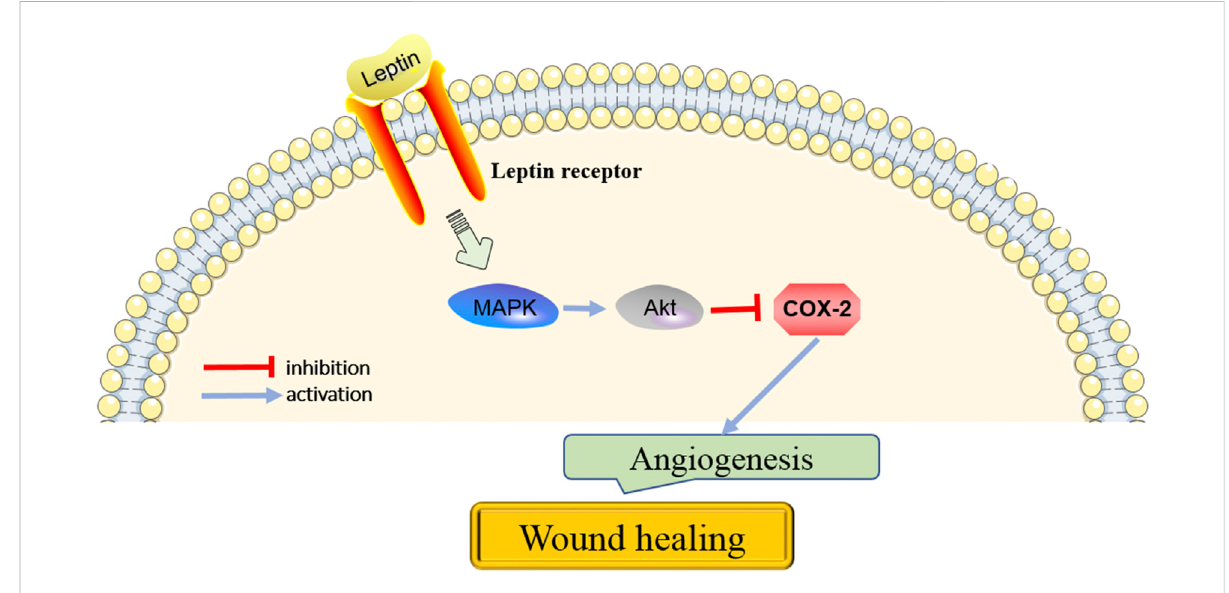
FIGURE 3 The key pathways in the action of leptin on angiogenesis for wound